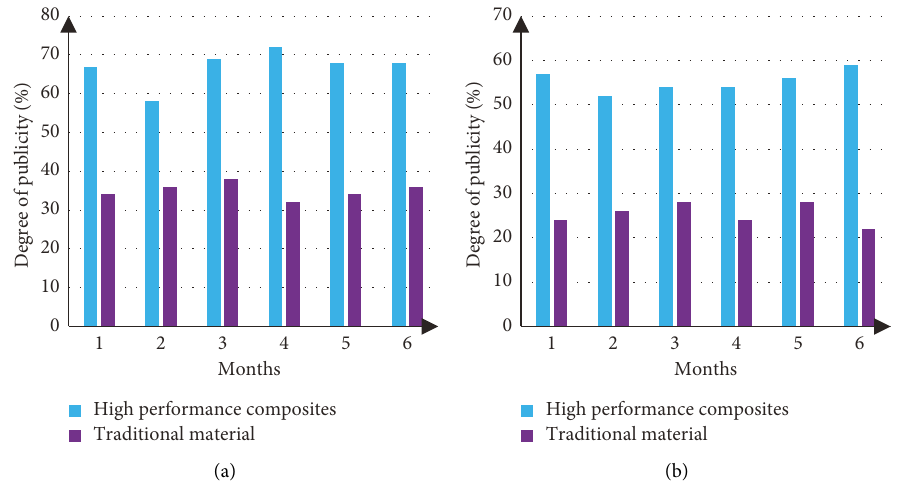
Figure 6: Results of sports brand publicity. (a) Big brand and (b) small brand.